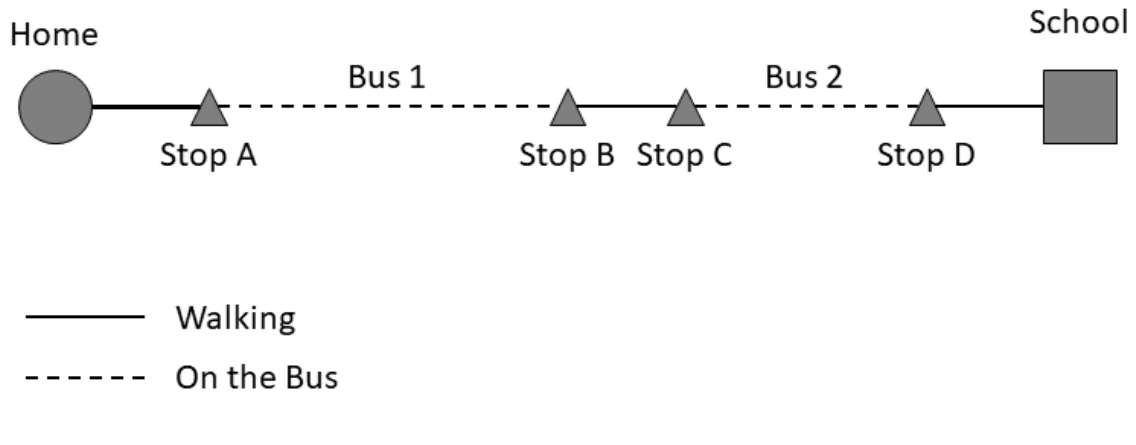
Figure 4 focuses in on one specific neighborhood in Baltimore. Harlem Park is located in the middle of the high–violent-crime area in central-west Baltimore. The figure shows block by block the violent-crime count for each street segment. Streets with no reported violent crime are drawn in gray, whereas those with reported crimes are drawn in black. Thicker lines indicate a larger number of crimes.